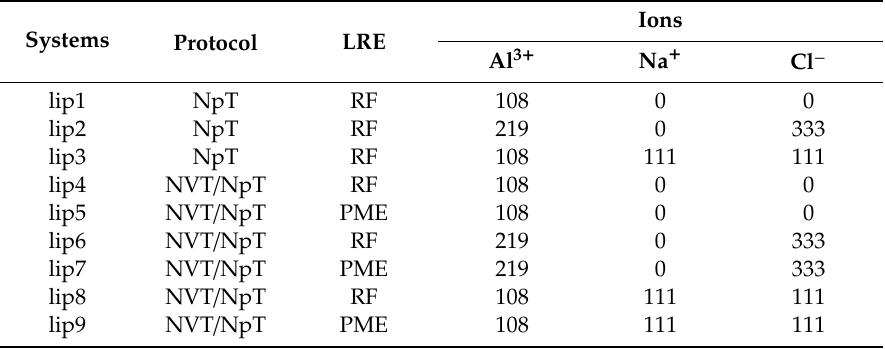
Table 2. MD simulations of lipid-A membranes in the presence of Al 3 + counterions treated via di ff erent equilibration protocols, long-range electrostatic (LRE) approximations, and concentration regimes (no additional salt, 150 mM of NaCl, 150 mM of AlCl 3 ). A pressure coupling constant τ p of 0.4 ps was applied to during the production phase for the simulations. The simulations were performed in